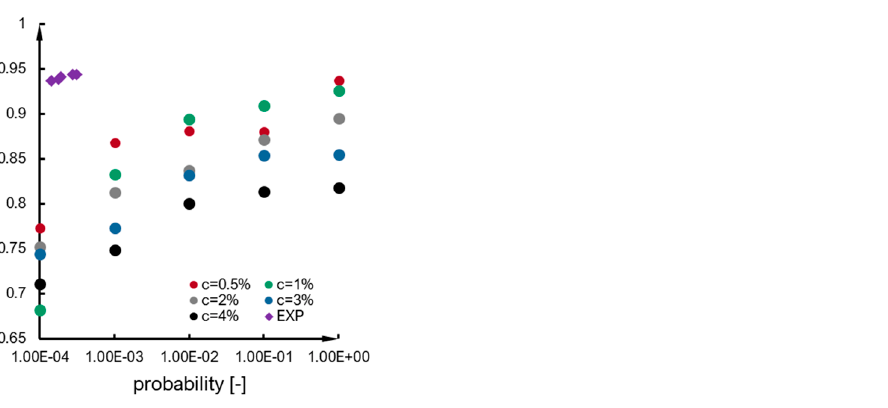
Figure 16. An alcogel’s porosity due to probability value—numerical vs. experimental results.